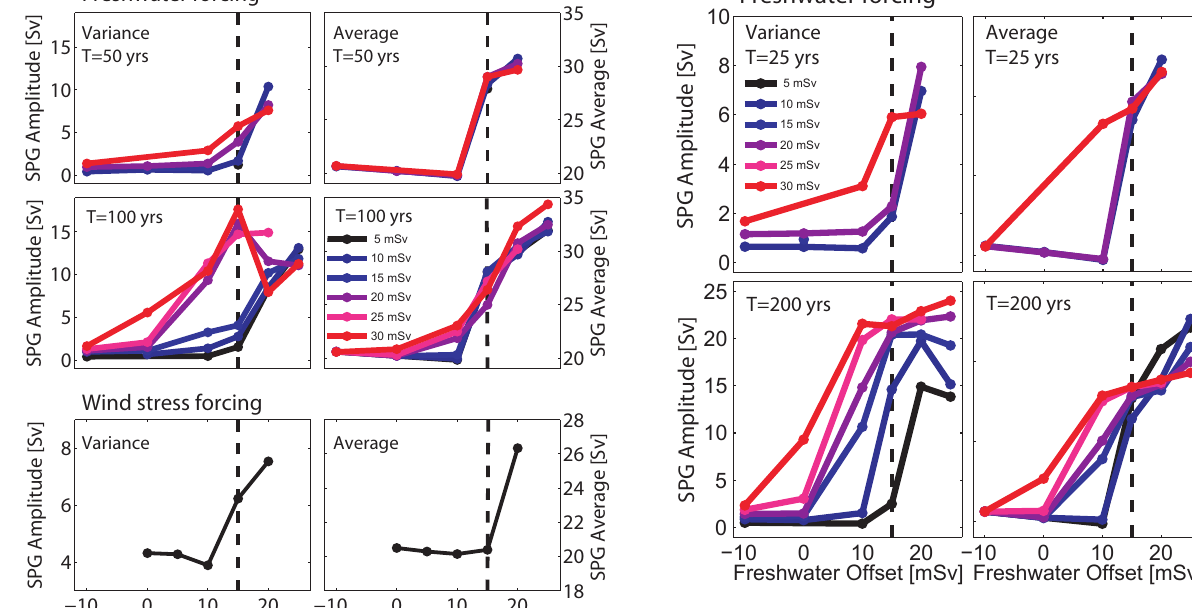
Fig. 6. Mean SPG strength and its variability for varying perturba- tion amplitude corresponding to Fig. 5, but for periods of 25 and 200yr. Different lines correspond to different forcing amplitudes as denoted in the